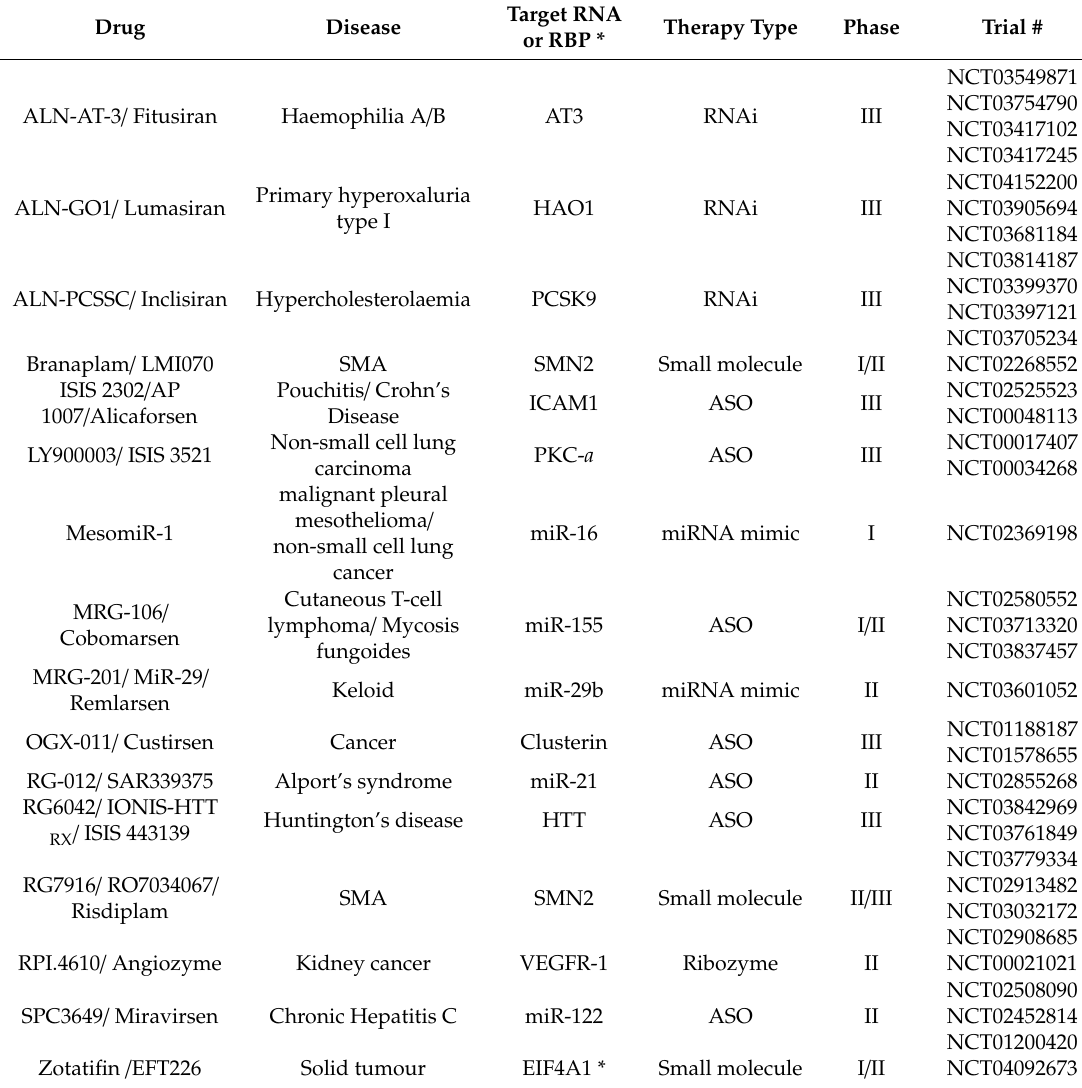
Table 2. Representative RNA-targeted therapies in clinical